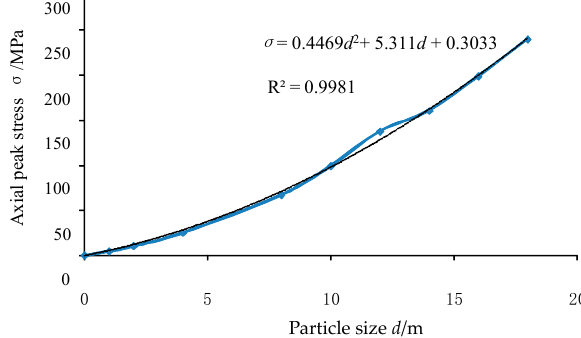
Figure 17. Axial stress-strain curve in plane strain numerical analysis.